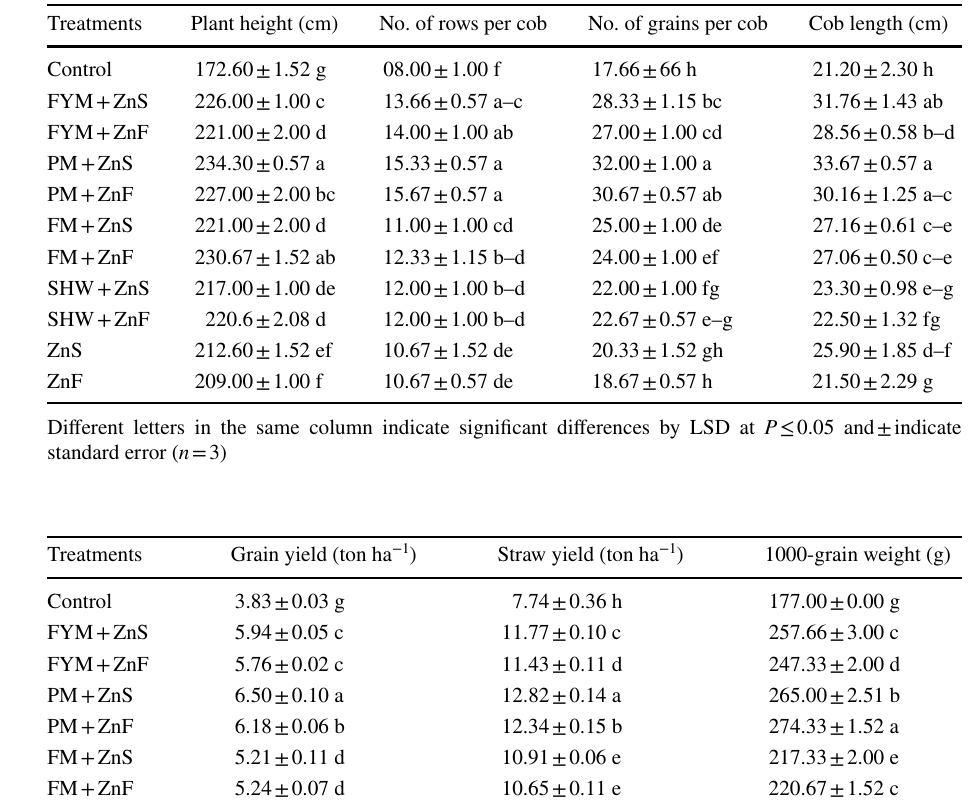
Table 2 Effect of organic manures and Zn fertilization on maize plant growth attributes